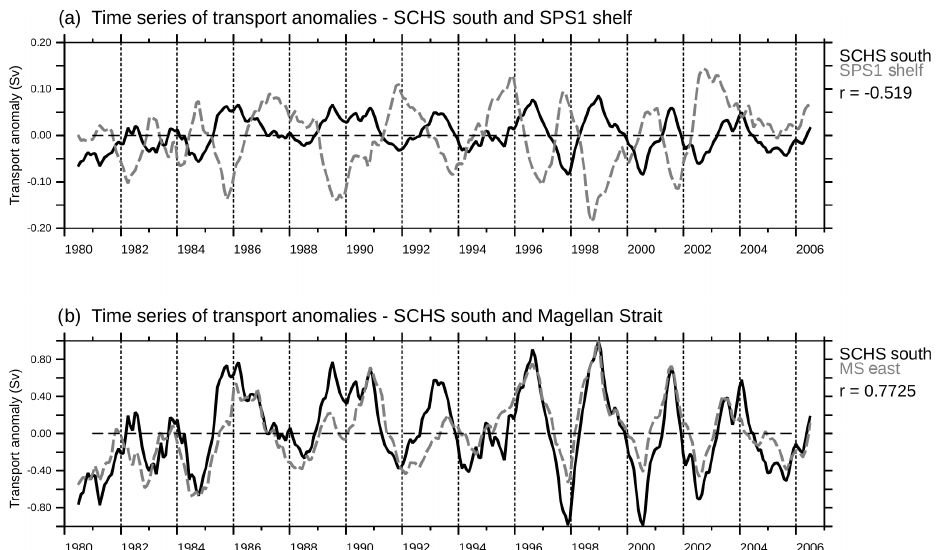
Figure 13. (a) Annual mean transport anomalies through the southern boundary of SCHS (black) and northward transport through SPS1 (grey). (b) Annual mean transport anomalies through the southern boundary of SCHS (black) and Pacific to Atlantic transport through the Atlantic mouth of the Magellan Strait (grey). The transports in (b) have been normalized with the maximum of each time series to help visualize the variability of the Magellan throughflow. The correlation between the transport anomalies is indicated on the right side of each panel. A 12-month running mean is applied to the data to filter the seasonal